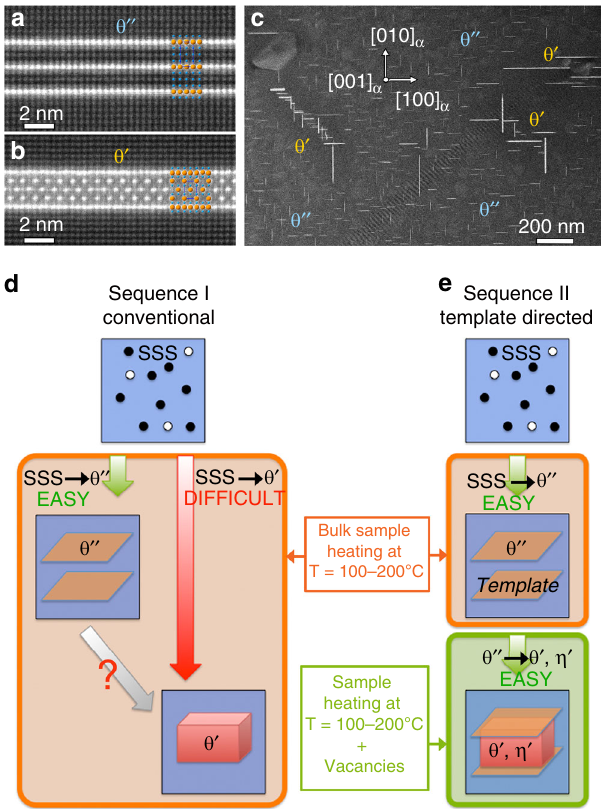
Fig. 1 Microstructure and crystal structure of precipitate phases involved in conventional and template-directed nucleation. a Typical θ ″ precipitate and b θ ′ precipitate in a conventionally heat-treated alloy, as viewed along <100> α by HAADF-STEM imaging . The crystal structures are overlaid, with Cu and Al atoms represented as orange and blue spheres, respectively. c Microstructural overview of a Al-1.7at.%Cu alloy conventionally heat- treated for 24 h at 160 °C, showing heterogeneous regions of θ ″ and θ ′ precipitates. d Schematics showing the nucleation sequence starting from a supersaturated solid solution (SSS) in conventional heat treatments and e in heat treatments enabling template-directed nucleation (TDN) of the existing phase θ ′ and a new phase η ′ on the template phase θ ″ . As will be shown, vacancies are the critical factor required for